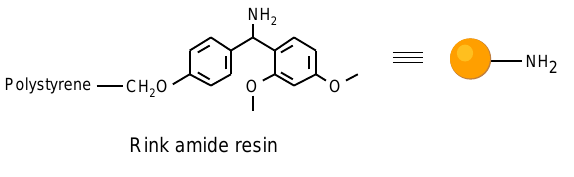
Figure 2. The Rink amide resin utilized as solid support.